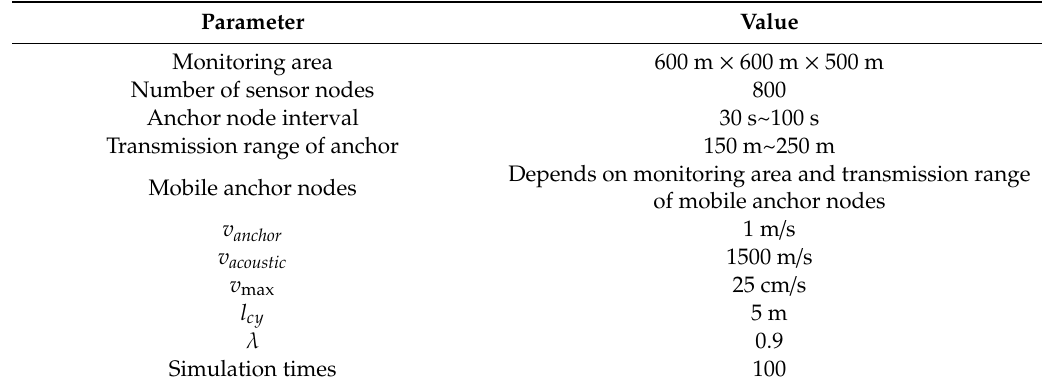
Figure 10. Deployment distribution of anchor nodes on the horizontal plane of the projection.